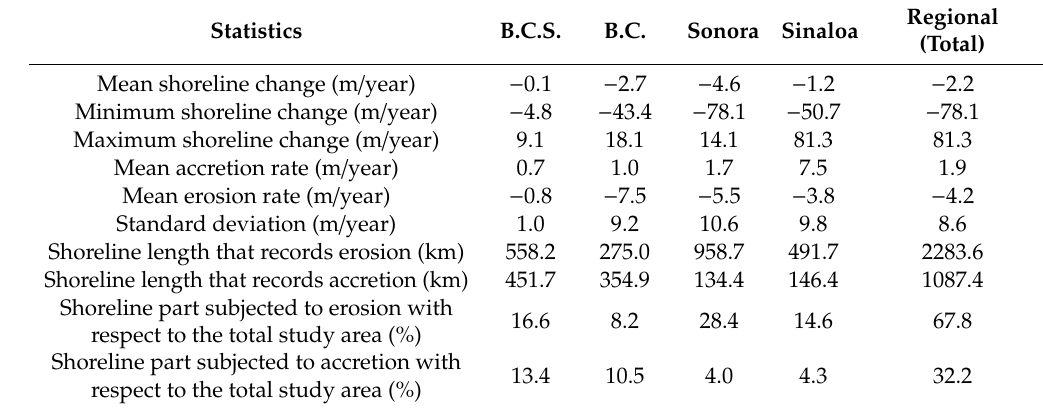
Figure 5. Multi-year means of H 99 , H s , T s and P at C1, C2 and C3 for the whole 40-year period (1980– 2019): ( a ) H 99 * ; ( b ) H s *; ( c ) T s * ; ( d ) P *.